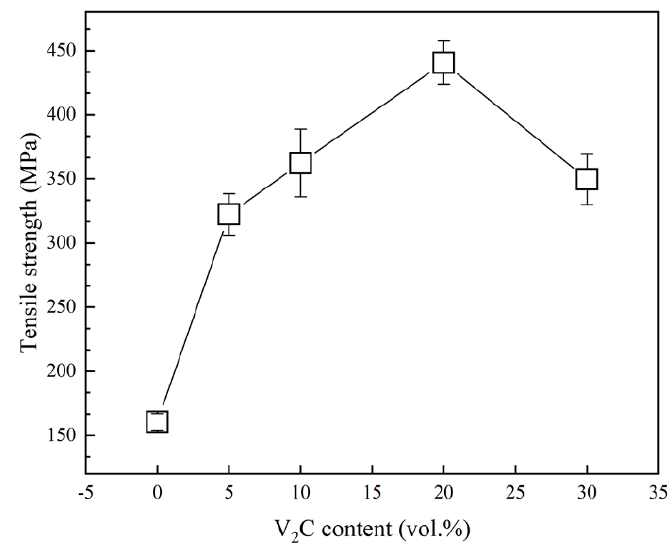
Figure 9. Tensile strength of Cu composites versus V 2 C content.